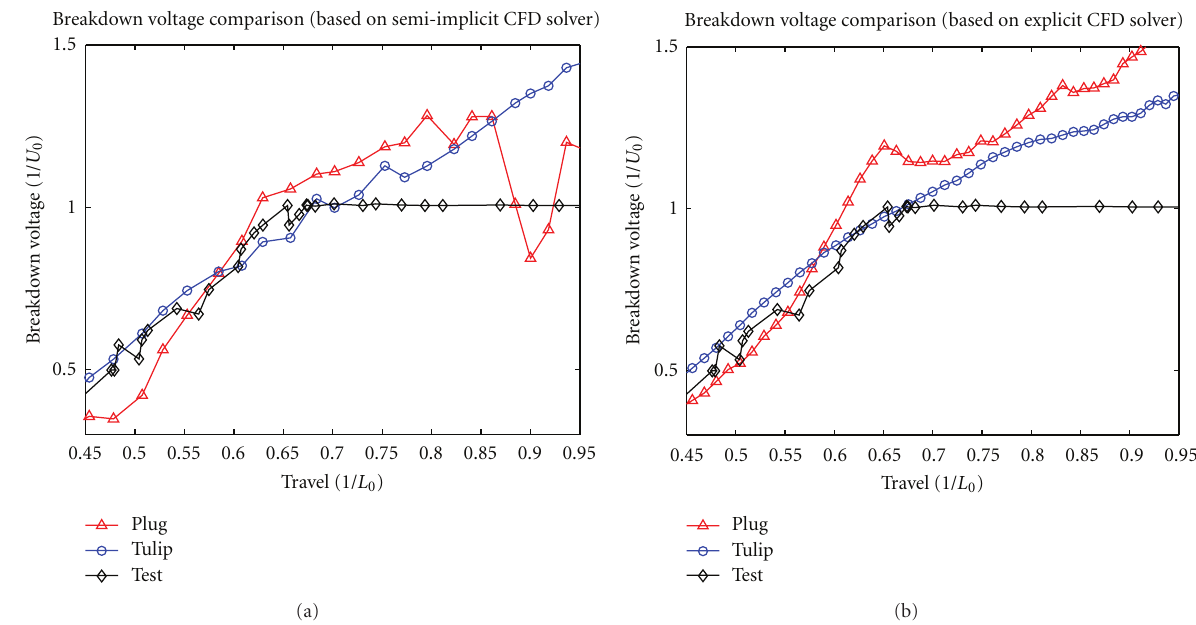
Figure 12: Comparison of the measured breakdown voltages with simulation with (a) SIMPLEC (b) Jameson